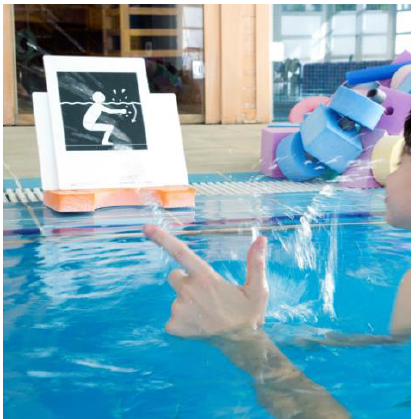
Figure 2. Example of visual prompting and attentional cues used in aquatic sensorimotor task.